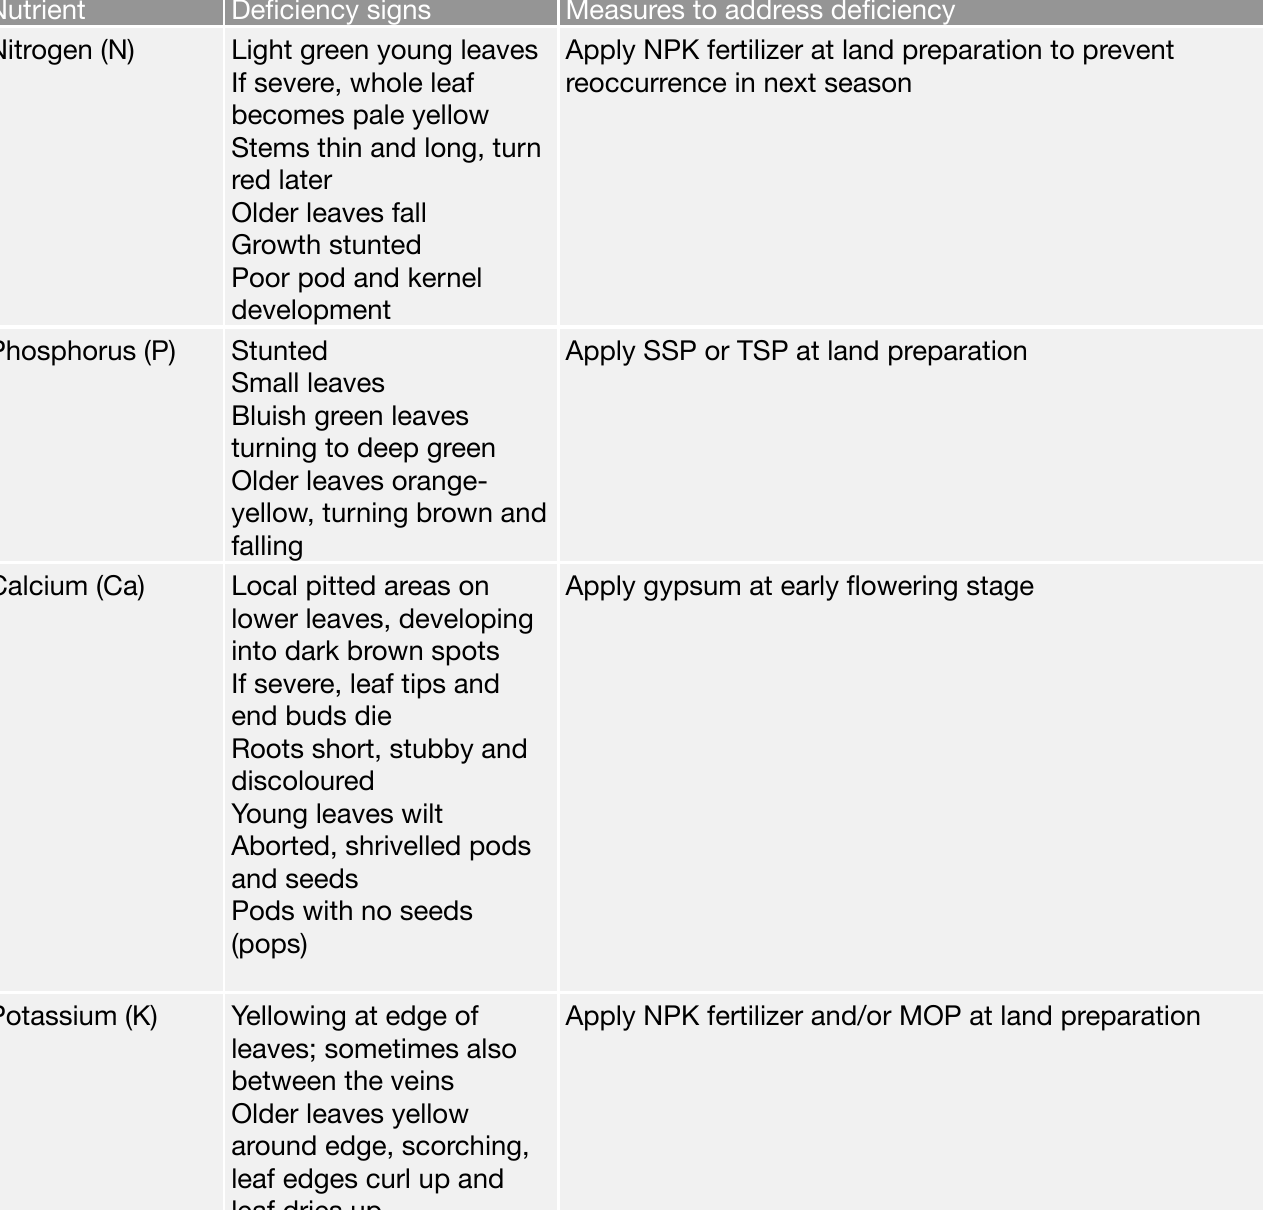
Table 4: Nutrient deficiency signs and measures to address in groundnut Nutrient Deficiency signs Nitrogen